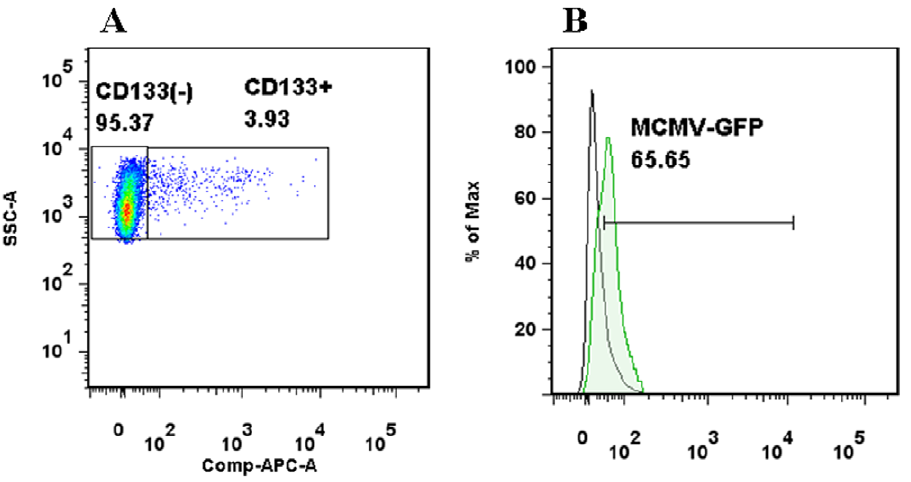
Figure 1. CD133( + ) cells are infected with MCMV in the developing brain. A . Day-old neonates from timed breeders were infected intra- cerebrally (i.c.) either with 200 TCID 50 of virulent, salivary gland passed recombinant MCMV expressing green fluorescent protein (GFP) or with mock inoculum, representing controls. A single cell suspension was prepared from the harvested brains by papain enzyme digestion at 7 d p.i. One million cells from both infected and control brains were stained for CD133, and analyzed by flow cytometry. B . Representative histogram showing MCMV infected CD133( + ) cells, the black line represents control and the green line was obtained from MCMV-infected brain. Data shown are representative of three independent experiments using cells prepared from P7 brains obtained from 4, 3 and 5 neonates,